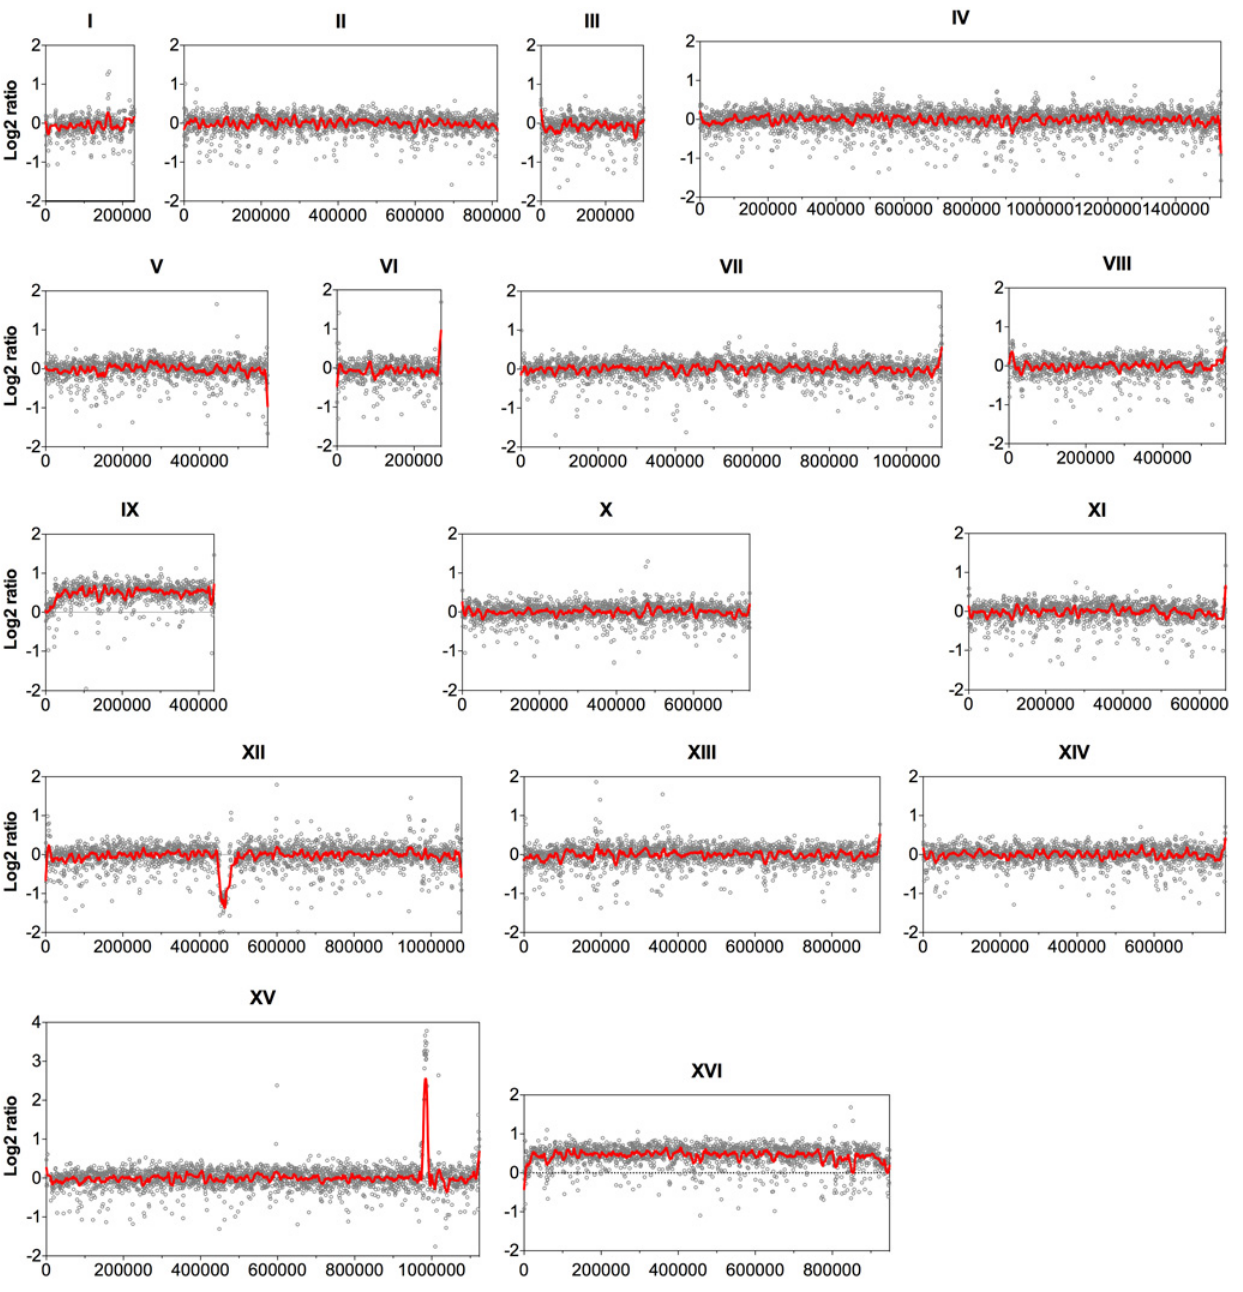
Fig 1. Comparison of the genome sequence coverage between the parent strain HDY.GUF5 and evolved strain GS1.11 – 26. Log2 ratio depicted from whole genome sequence coverage between the parental and the evolved strain is presented for each of the 16 chromosomes. Each grey circle represents the value of the log2 ratio obtained from the sequence coverage calculated for averaged sliding windows of 500 nucleotide positions. The red line indicates the smoother trend calculated by moving average values of 10,000 bp.